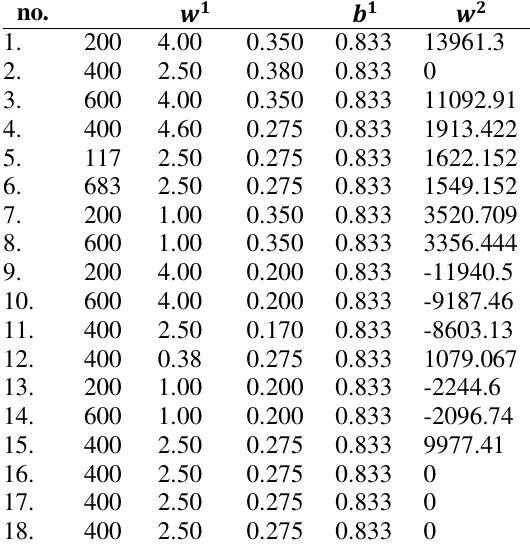
The network weights matrices and bias. & (cid:29)